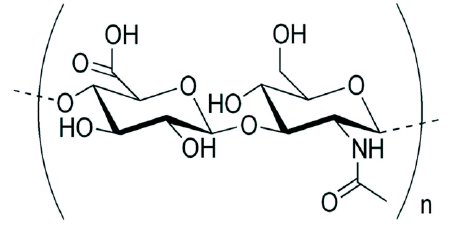
Figure 1. Chemical structure of a hyaluronic acid molecule [4].